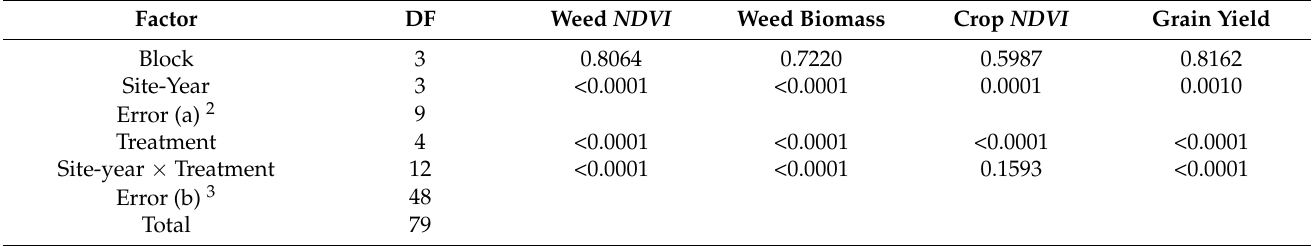
Table 3. The effects of site-years, treatments, and site-year by treatment interactions on weed NDVI , weed biomass, crop NDVI , and grain yield. Values for weed NDVI , weed biomass (g m − 2 ), crop NDVI , and grain yield (kg ha − 1 ) were compared between the four site-years (across herbicide treatments) and the five herbicide treatments (across site-years). In the upper part of the table, the P values are listed. The remaining parts of the table show the mean values across site-years and herbicide treatments are presented with standard errors of measurements cited in